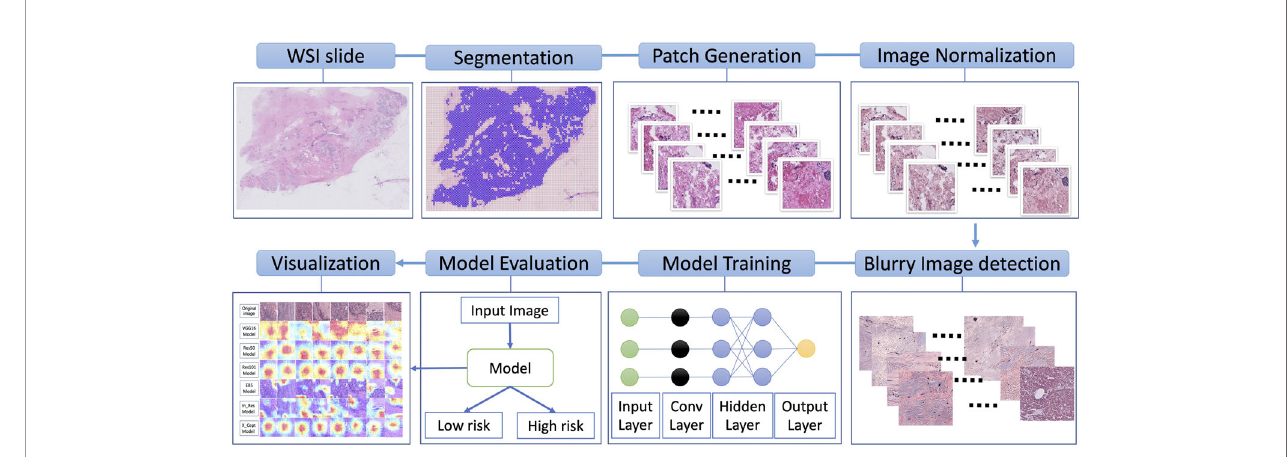
FIGURE 1 | Overall schematic work fl ow. The whole slide images (WSI) were used to generate smaller patches of 512x512 pixels. These small patches then underwent normalization for hematoxylin and eosin staining. Next, blurry and pixelated images were removed using the Laplacian algorithm. The retained images were used for model training, validation, and testing. Finally, to illustrate how different models learn to distinguish low-risk and high-risk samples, we used gradient- weighted class activation to create a heatmap for each